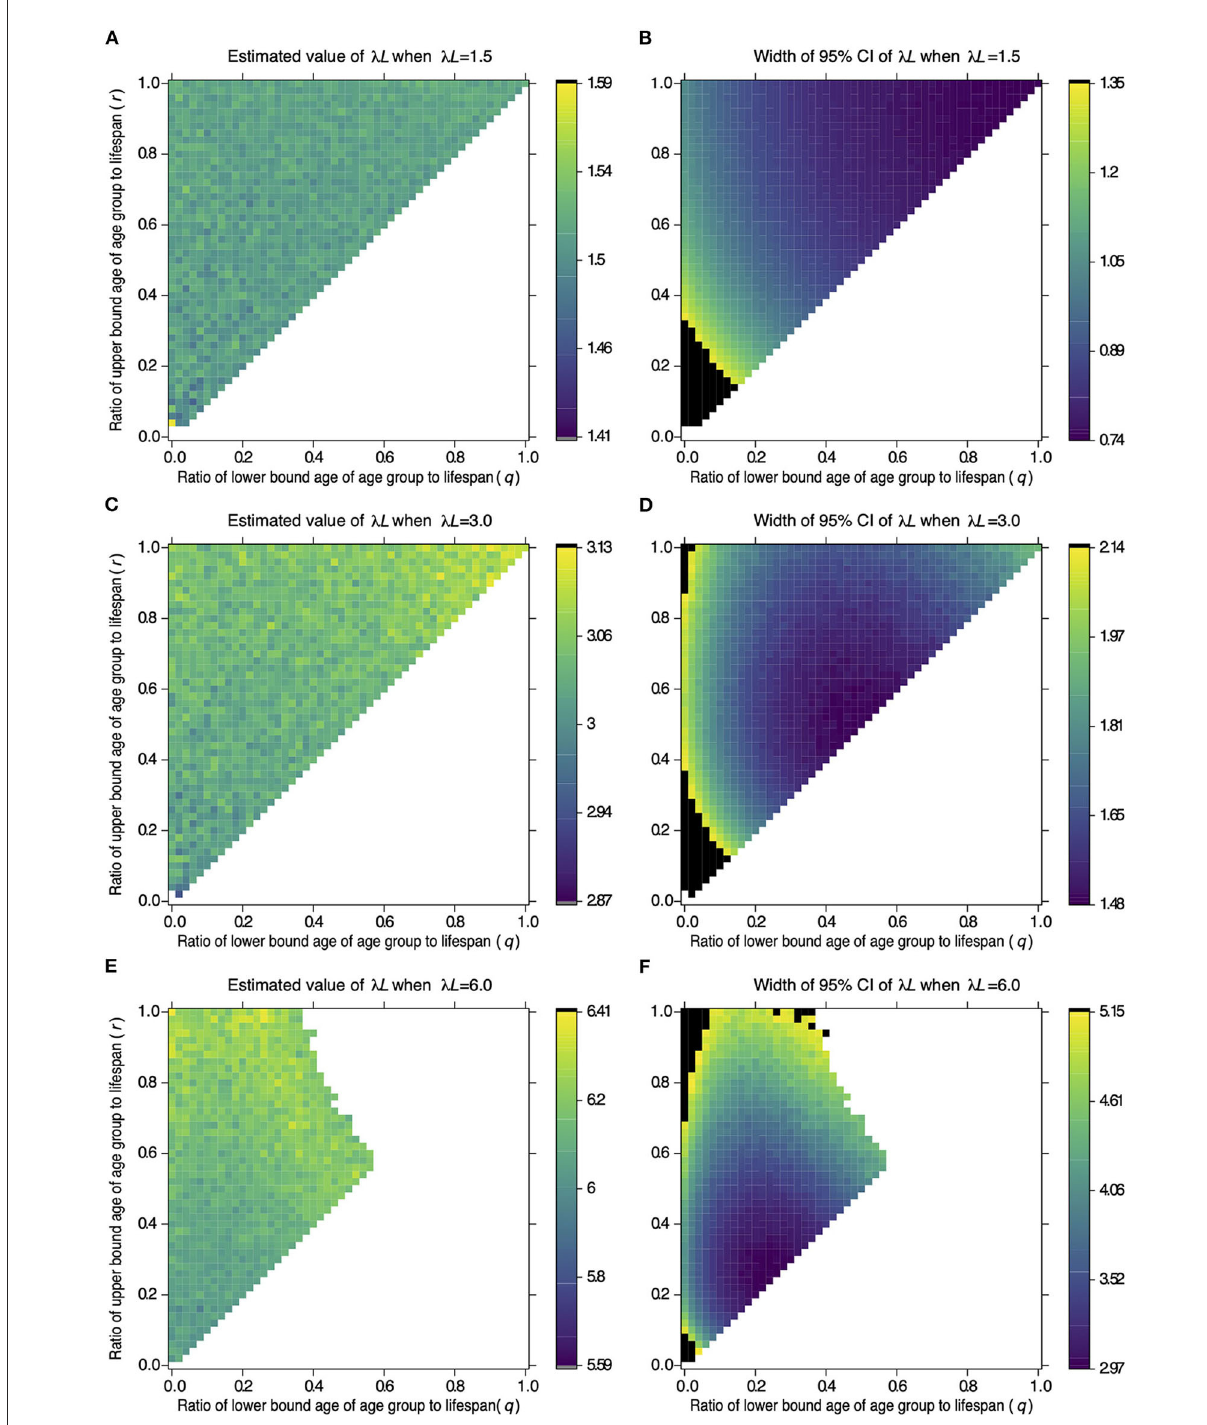
FIGURE1 Effect of the target age group on the estimate of λ L and its 95% CI width. The color of a cell in (A,C,E) represents the value of λ L estimated from samples of the target age group defined by age parameters q and r on the x - and y -axis. A cell in (B,D,F) represents the width of 95% CI of λ L estimated from the samples as (A,C,E) , respectively. Values of λ L and 95% CI width were estimated from 100 samples drawn from the target population. Serological surveillance was simulated 1,000 times under settings where λ L = 1.5 (A,B) , λ L = 3.0 (C,D) , and λ L = 6.0 (E,F) . The color of a cell represents the averaged value in 1,000 repetitions, and the color key next to each panel shows colors associated with the values. The black cells in (B,D,F) represent widths above the 95th percentile of all widths of CI. The white cells represent the combination of sampling age parameters. The results are not available to estimate 95% CI of λ L by the profile likelihood method in more than 5% of